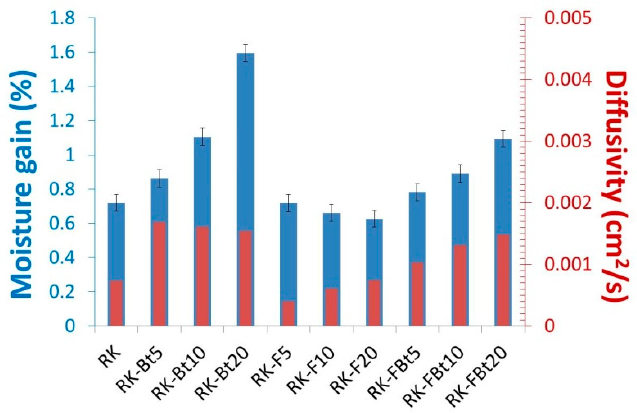
ff usivity for all tested composites.